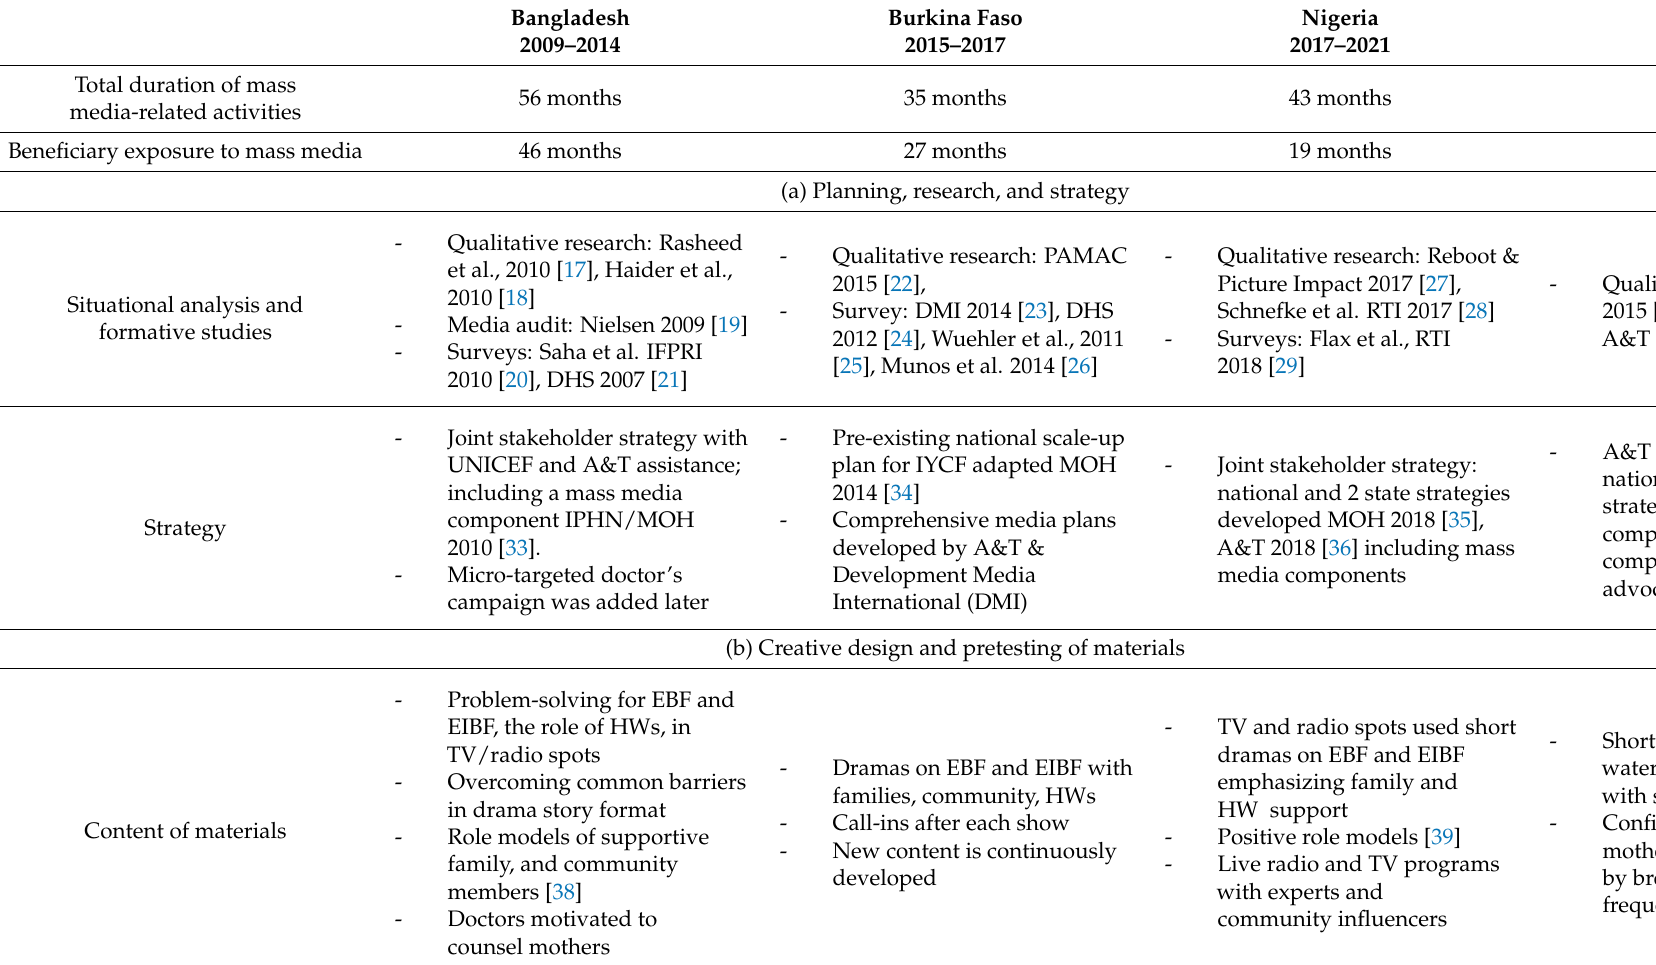
Table 1. Program Components and Timing of Mass Media Interventions in Four